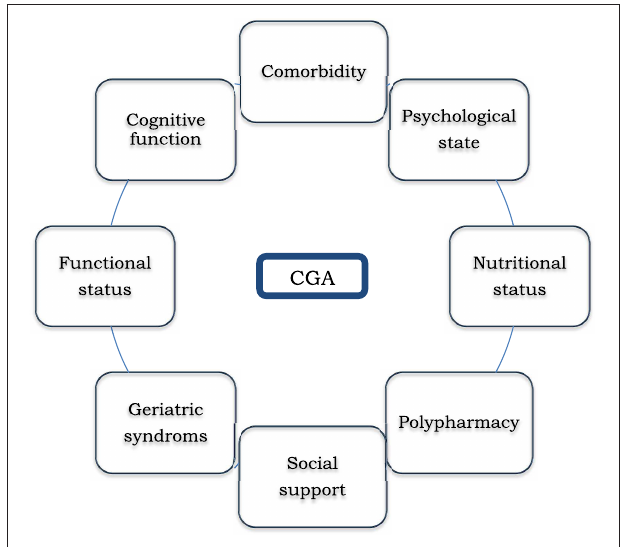
FIGURE 3 | Domains evaluated in Comprehensive Geriatric Assessment